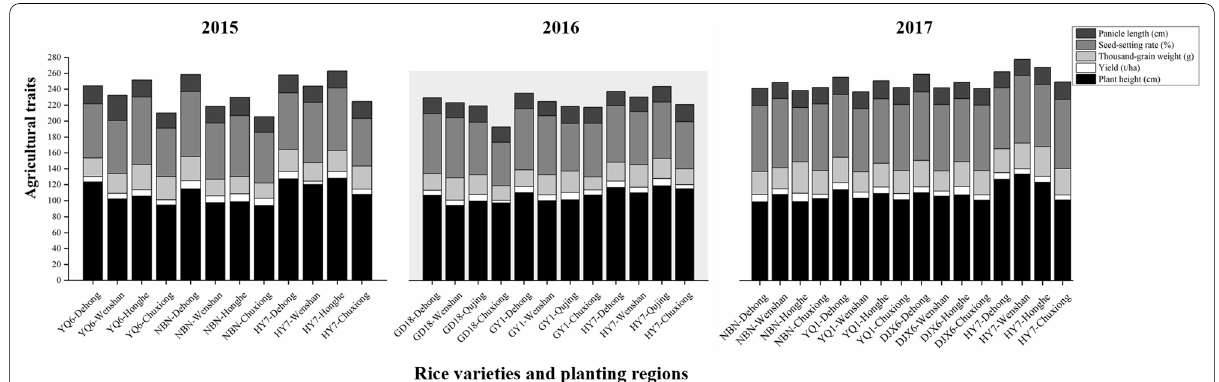
Fig. 5 The yield and agronomic traits of multi‑genotype varieties in four rice‑planting regions. Six multi‑genotype varieties (DJX6, GD18, GY1, YQ1, YQ6, NBN) were evaluated during 2015–2017. HongYou‑7 (HY7), a local high‑yielding and disease‑resistant variety was used as the control